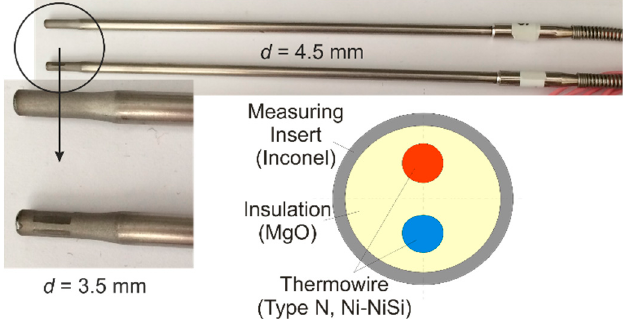
Figure 9. Thermocouple type N.